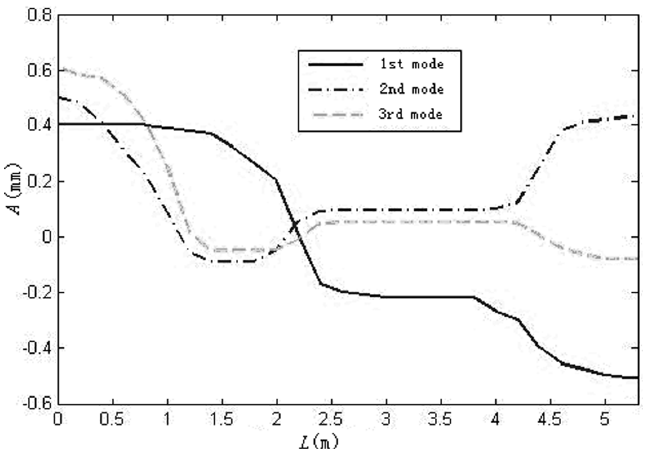
Fig. 4. The fi rst three natural torsional modes of the